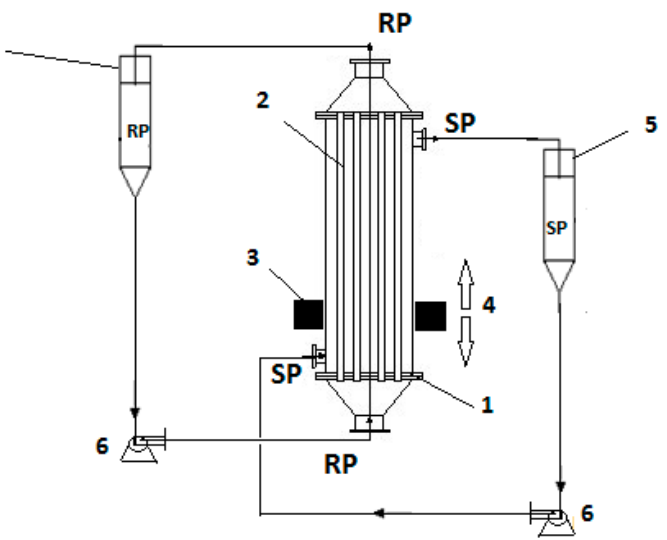
Figure 2. Schematic presentation of the pertraction module and its principal components: 1–pertraction module, 2—hollow-fiber membrane, 3—annular ferrite, 4—oscillatory system, 5—reservoirs: SP-source phase, RP-receiving phase, 6-pumps.